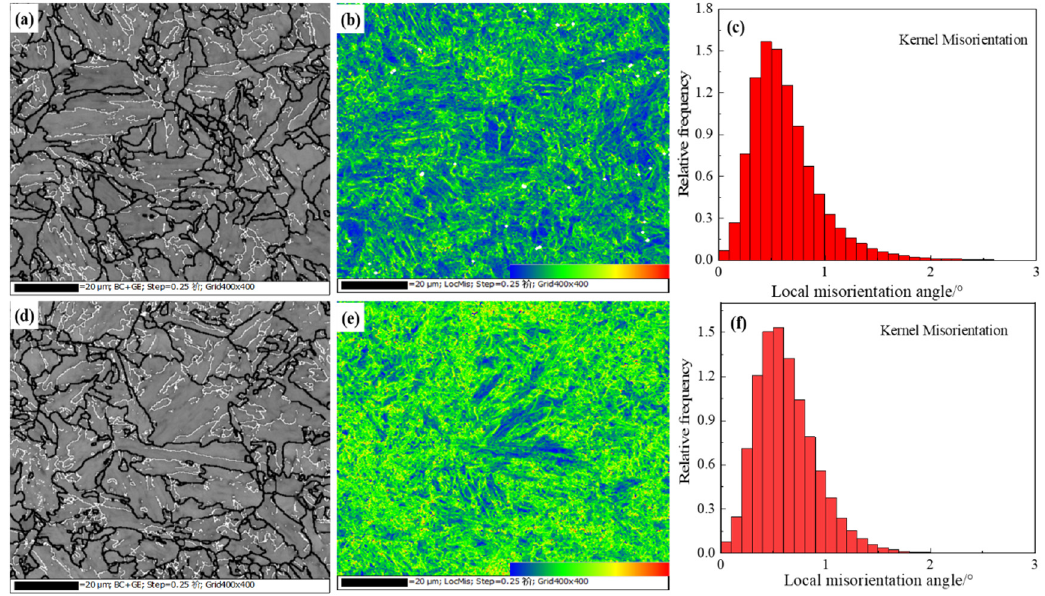
Figure 5. The grain boundary and kernel average misorientation map for compression ratio. ( a – c ) 0.35; ( d – f ) 0.5.